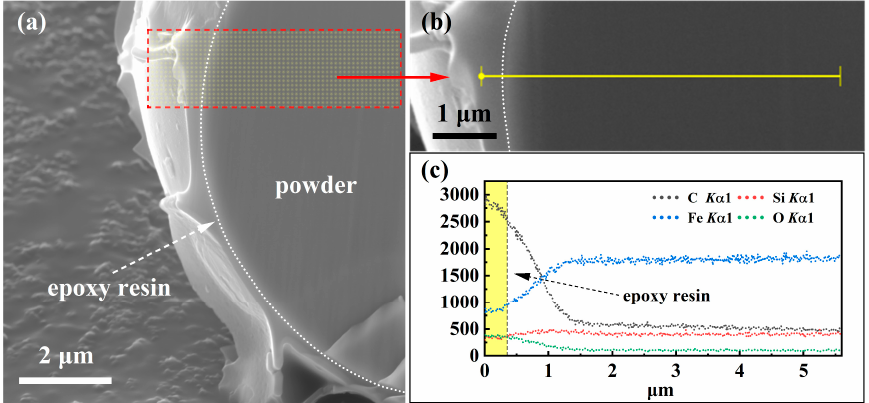
Figure 2. ( a , b ) Cross-section morphology and ( c ) corresponding main elements distribution lines of a selected powder inside the Fe 74.75 Si 8 B 10 P 3 C 2 Nb 1.5 Cu 0.75 NPCs.